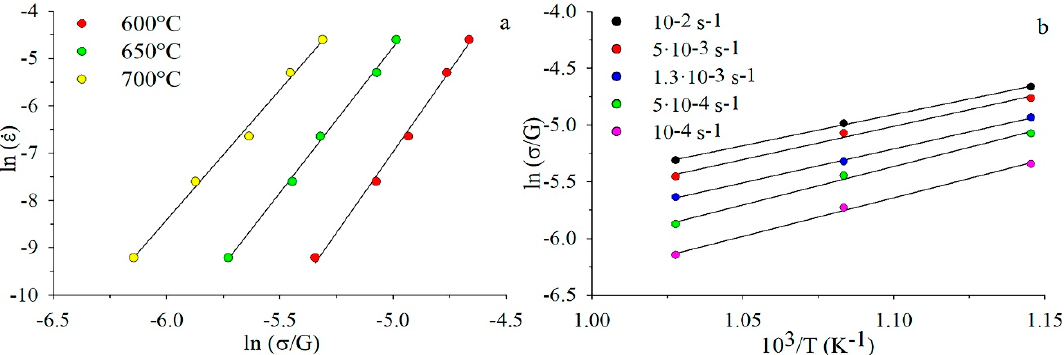
• · ) - ln( σ /G) ( a ) and ln( σ /G) – 10 3 /T ( b ) in the higher temperature ε ) − ln( σ / G) ( a ) and ln( σ / G) – 10 3 / T ( b ) in the higher temperature